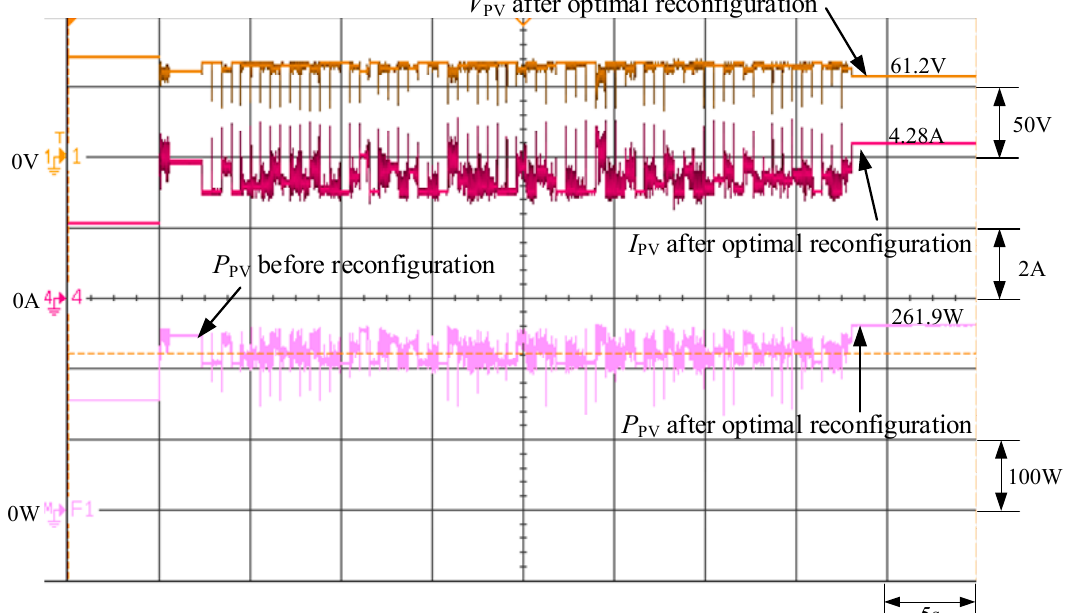
Figure 12. Response to an optimization request in a Case 1 array configuration.